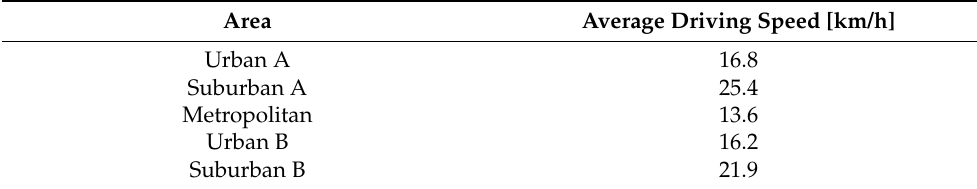
Table 6. Average speed in repeated measurement.